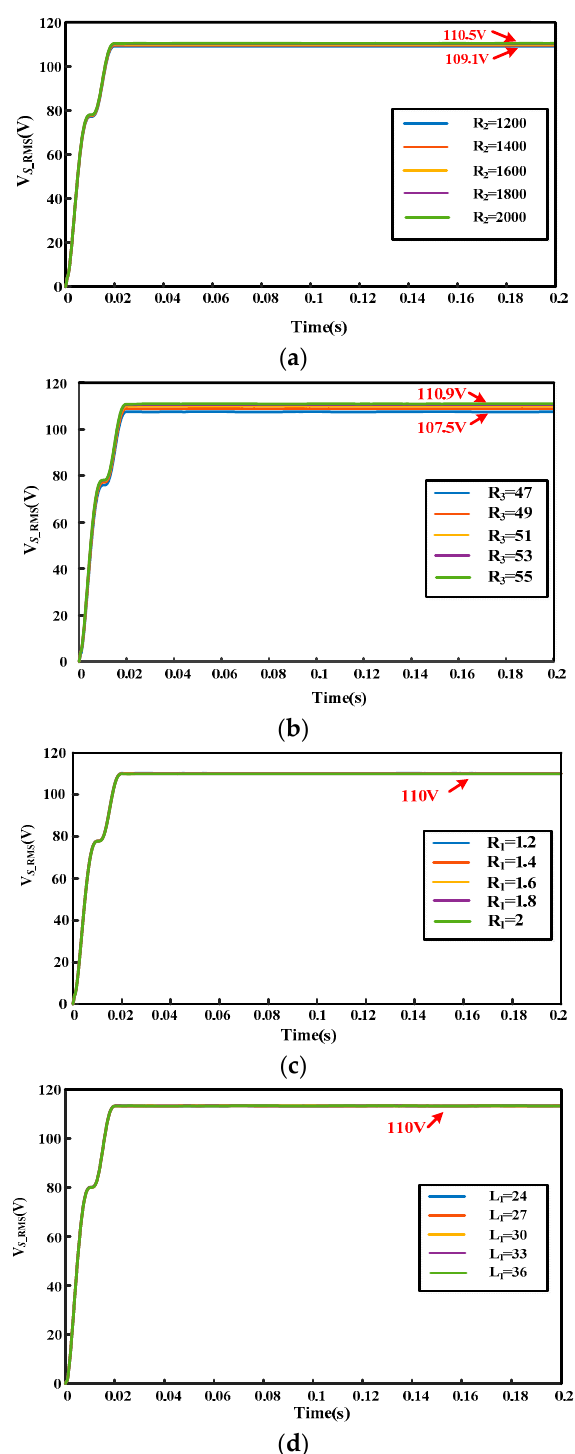
Figure 9. The sensitivity analysis based on dead-beat with the observer and δ control. ( a ) CL varies; ( b ) non-critical load (NCL) varies; ( c ) Line resistance varies; ( d ) Line inductance varies.